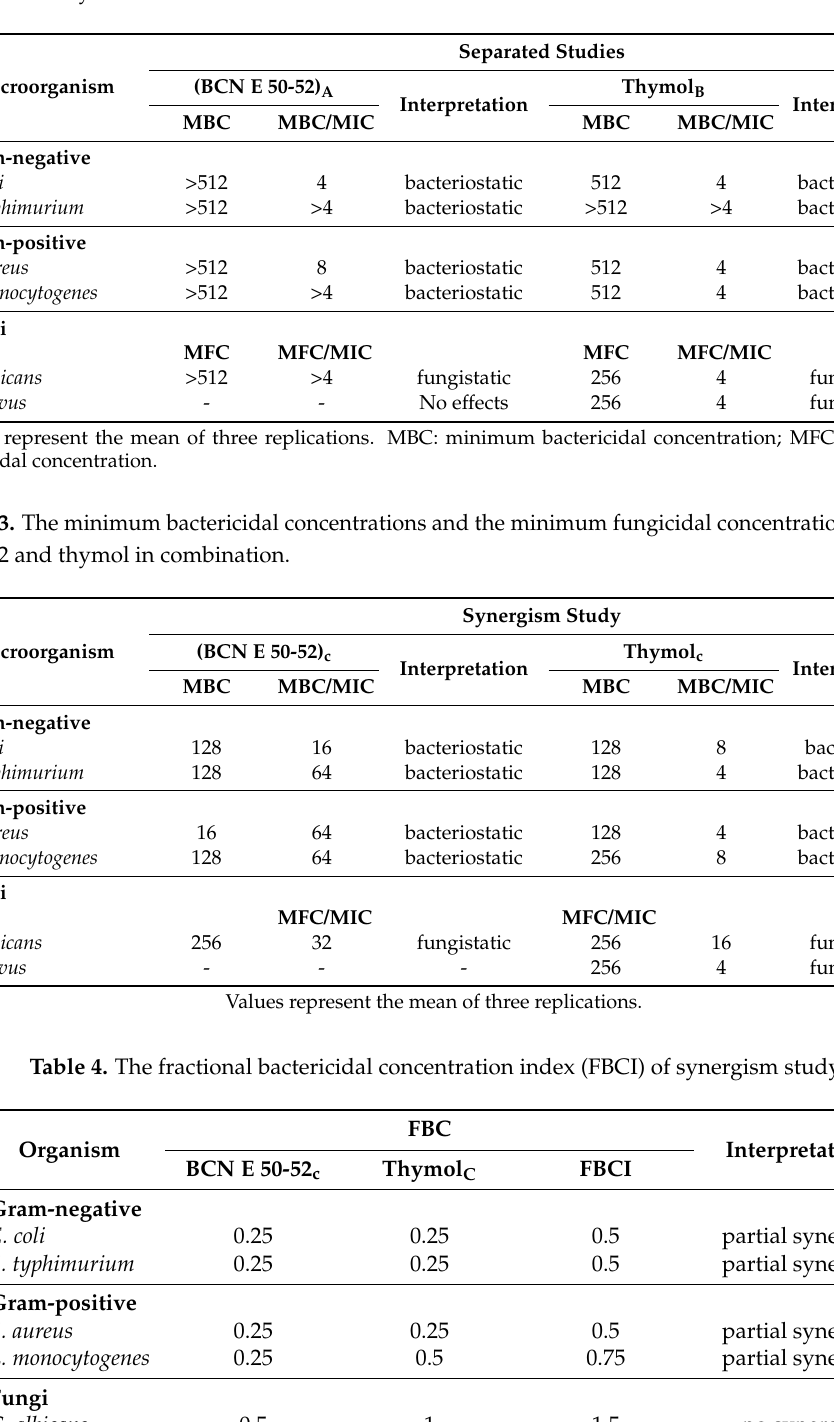
Table 2. The minimum bactericidal concentrations and the minimum fungicidal concentrations of BCN E 50-52 and thymol.